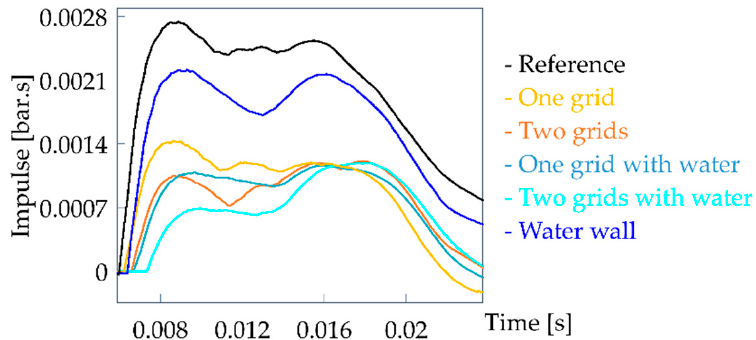
Figure 14. Reflected impulse measured on the wall for one test of each configuration. One reference test is also shown.